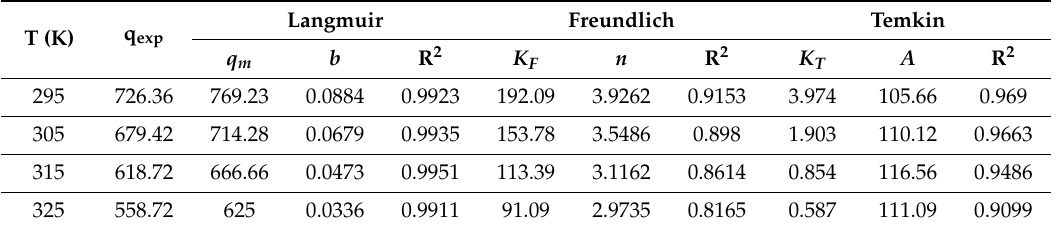
Table 2. Temkin, Langmuir and Freundlich constants for sorption of RB on MIL-100(Fe) @Fe 3 O 4 @AC.